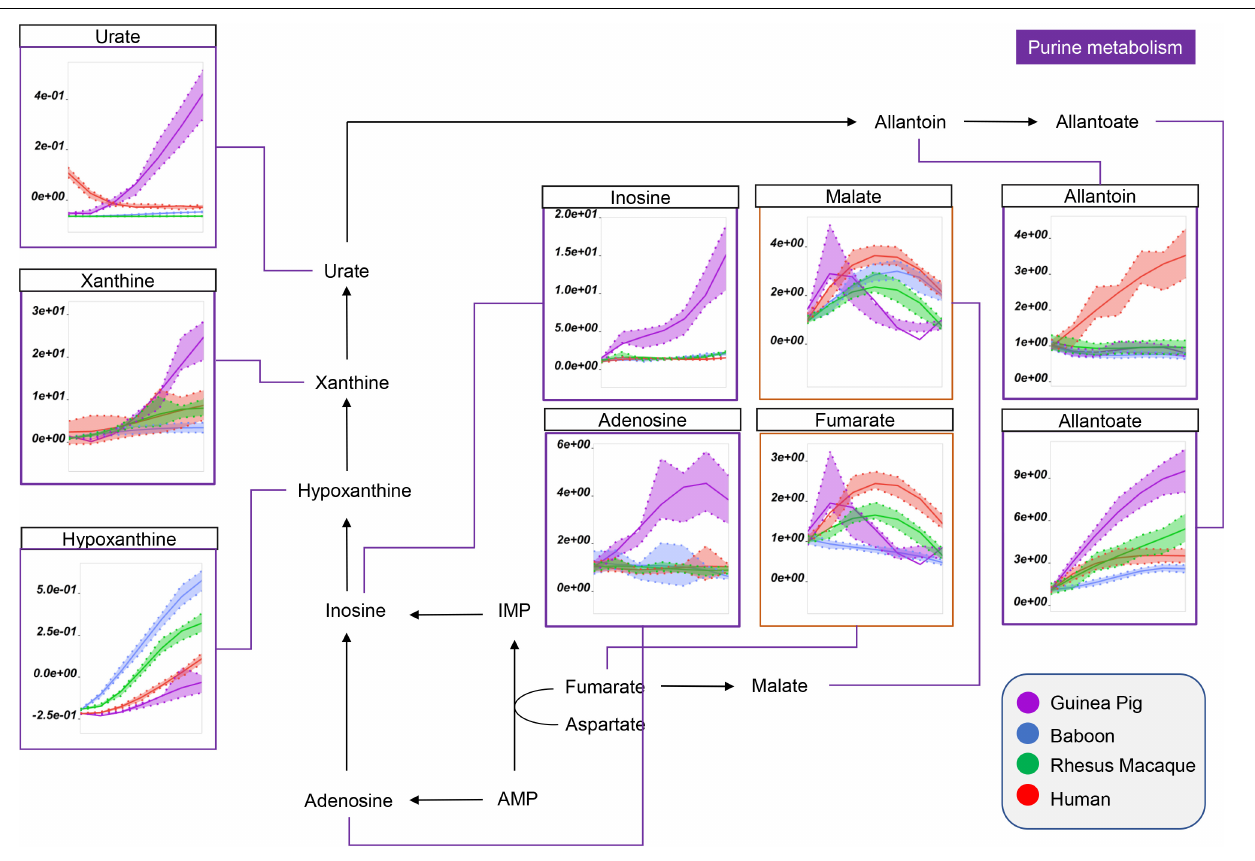
FIGURE 4 | Impact of storage on purine oxidation and carboxylic acid metabolism in RBCs from guinea pigs (violet), baboons (blue), rhesus macaques (green), and humans (red). Line plots indicate metabolite medians (lighter colored areas are ranges) normalized to measurements in fresh, non-stored blood (day 0) and autoscale normalized across groups. All metabolites are significant by ANOVA (FDR corrected– p <